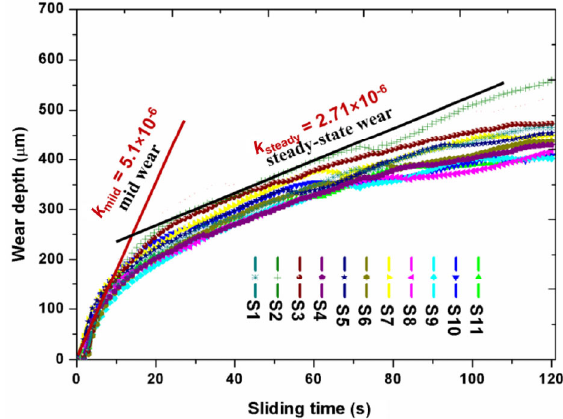
Fig. 6 Variation of wear depth with sliding time for pin samples, S1 − S11 ( F N = 200 N, N rot = 500 rpm, sliding time = 2 min).